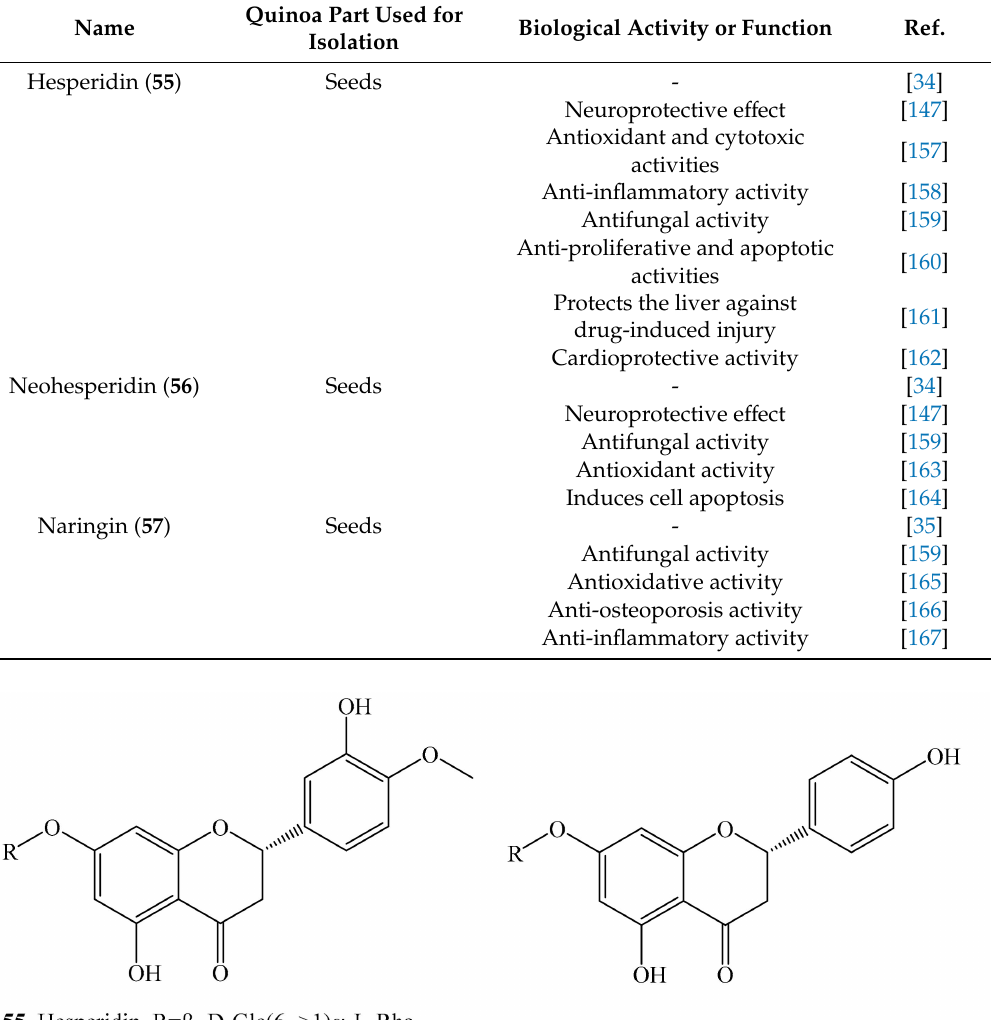
Table 5. Flavanones and their biological activities.